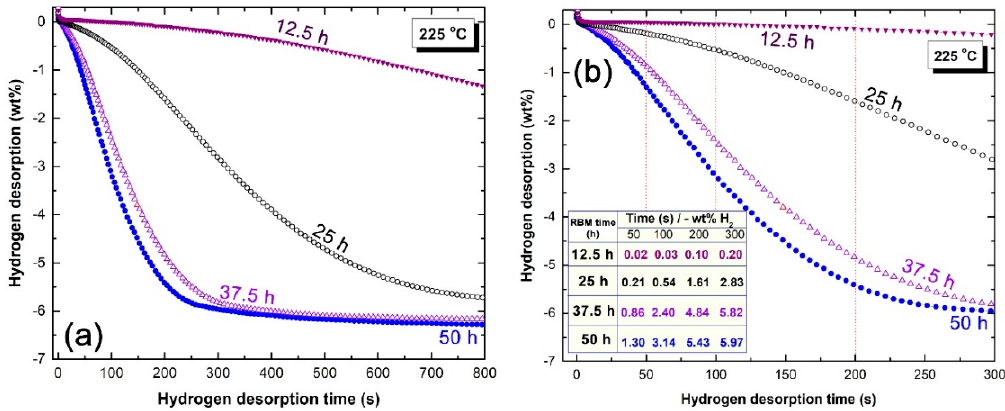
Figure 11. ( a ) Dehydrogenation kinetics, measured at 225 °C under 200 mbar of hydrogen for MgH 2 powders milled with Zr 2 Ni balls after different RBM times of 12.5, 25, 37.5 and 50 h. The dehydrogenation behaviors of the samples shown in ( a ) are displayed in ( b ) with a different scale of desorption time.